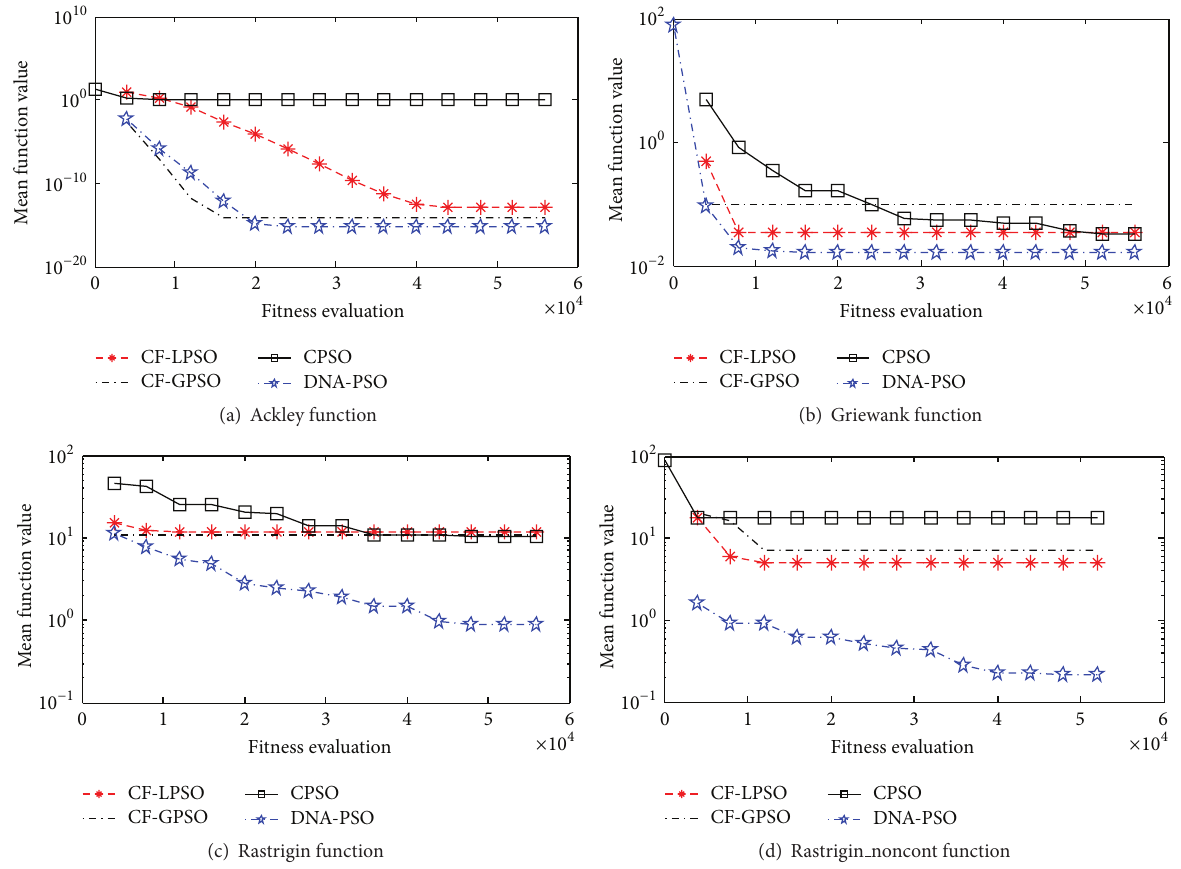
Figure 5: Rotated function convergence figure.